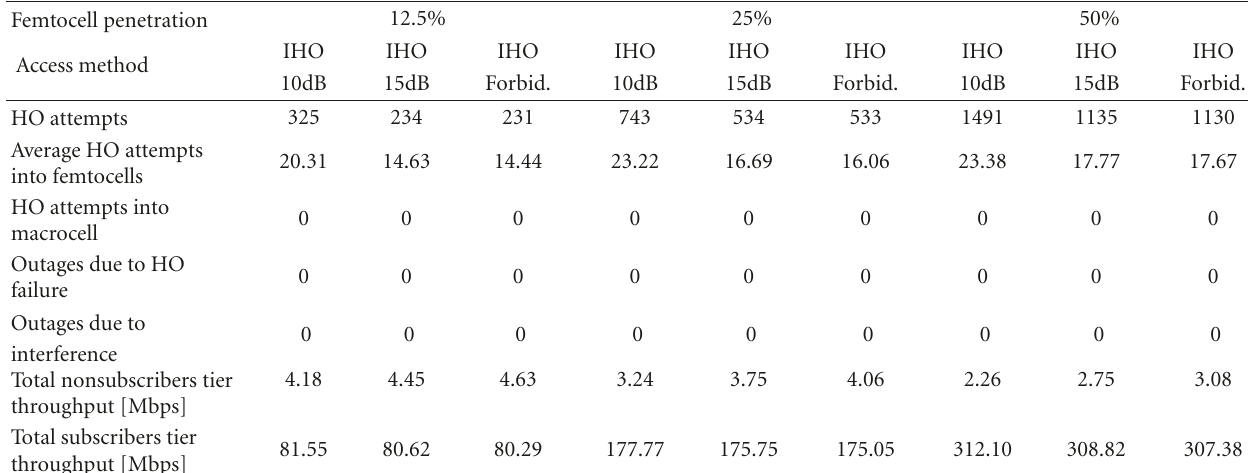
Table 9: Performance Comparison for Setup 4 (800 s